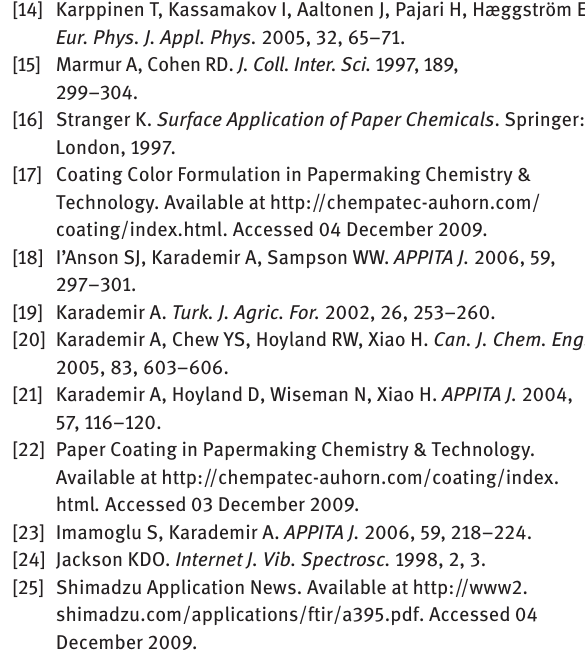
coated papers behaved in a very similar manner (Figure 4 ). The water droplet disappeared on sheets within 6 min. This shows that matte coating would not change the print- ing operation if water-based ink is to be used.